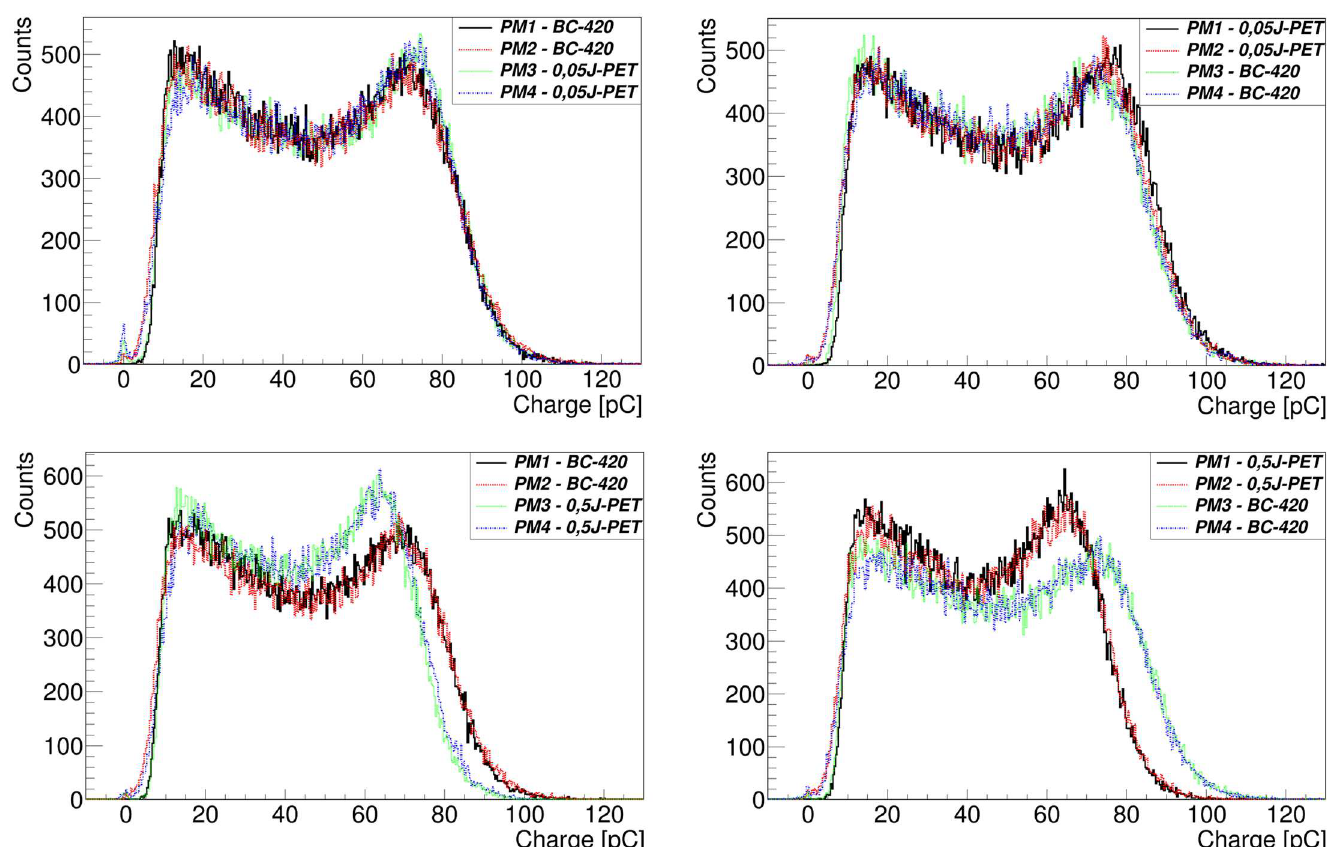
Fig 7. Charge spectrameasuredwith the J-PET and BC-420 scintillator. PM1, PM2, PM3, PM4 used in the legenddenote photomultipliers indicated in Fig 3. In the left side charge spectra of the J-PET scintillator(0.05J-PET or 0.5J-PET) measuredwith photomultipliers PM1 and PM2 are comparedto the spectra of BC-420scintillatormeasured with the same pair of photomultipliers. The number in the name of the J-PET scintillatorindicatesthe concentration of WLS in ‰. In the right side spectra of the J-PET scintillators are comparedto spectra of BC-420 measuredwith the same pair of photomultipliers: PM3 and PM4. The difference betweenthe spectra for the low values of charge are due to the fact that PM1 and PM3 were used in the trigger. The differencesat large charge (at the Compton edge) are due to the differencesin the light yield.